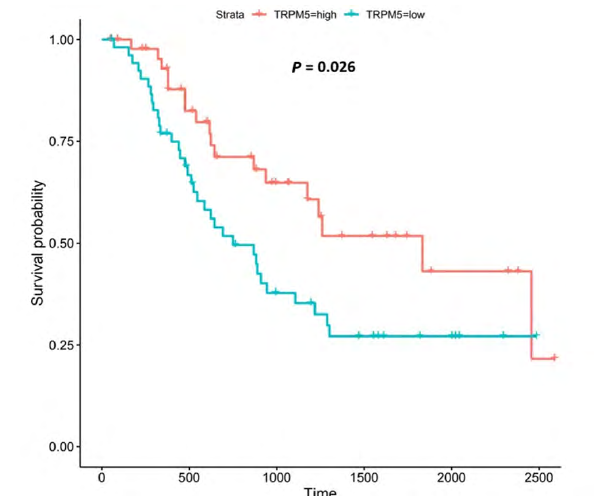
Figure 12. Kaplan-Meier survival plot for TRPM5 . Details as described in Figure 6